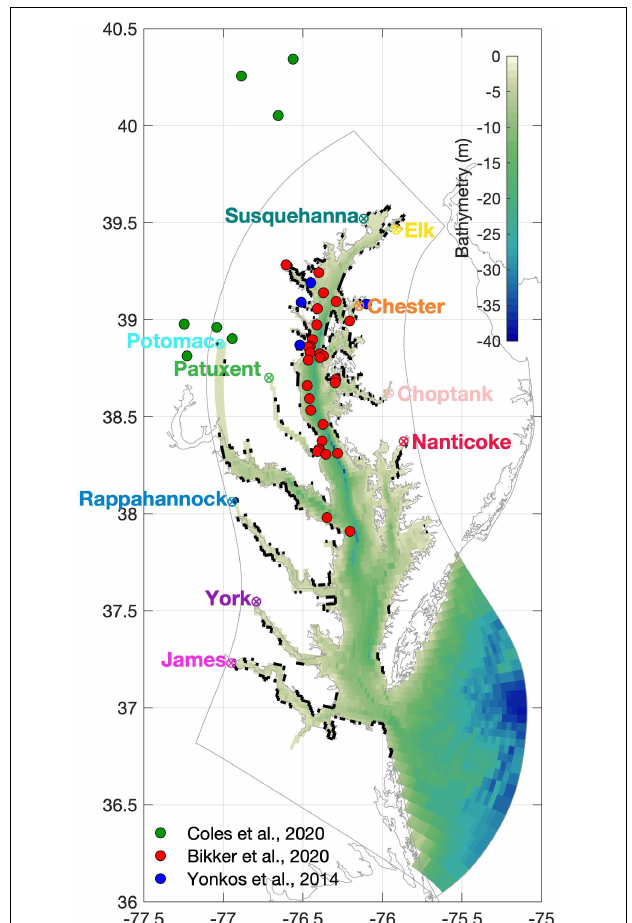
FIGURE 1 | ChesROMS model bathymetry and the 10 locations where particles are released into the model. Locations of observations from three different studies are also shown. Black segments along coastline are considered armored in the particle tracking